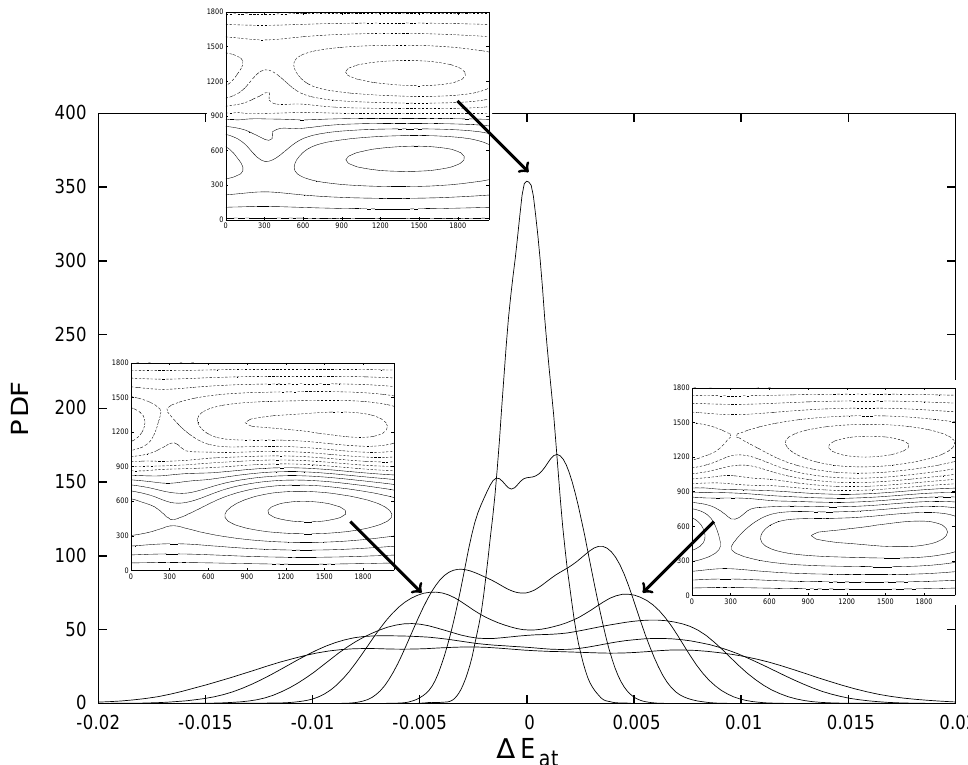
Fig. 12. Estimated normalized probability density functions (PDFs) of 1E at obtained for σ = 0 . 67 and for seven times series with the Fig. 12: Estimated normalized probability density functions (PDFs) of ∆ E at obtained for σ = 0 . 67 following α -values: 0.07, 0.08, 0.09, 0.10, 0.11, 0.12, and 0.13. The sharpest, most peaked PDF is for the smallest α -value, α = 0 . 07; the and for seven times series with the following α -values: 0.07, 0.08, 0.09, 0.10, 0.11, 0.12, and 0.13. flattest is for the largest value, α = 0 . 13. The inserts are the mean states computed with ( 1E at < 0; α = 0 . 1) on the left; ( α = 0 . 07) for the peak of the PDF in the middle; and ( 1E at > 0; α = 0 . 1) on the The sharpest, most peaked PDF is for the smallest α -value, α = 0 . 07 , the flattest is for the largest value, α = 0 . 13 . The inserts are the mean states computed with ( ∆ E at < 0 ; α = 0 . 1 ) on the left; ( ∆ E at = 0 ; α = 0 . 07 ) for the peak of the PDF in the middle; and ( ∆ E at > 0 ; α = 0 . 1 ) on the right.